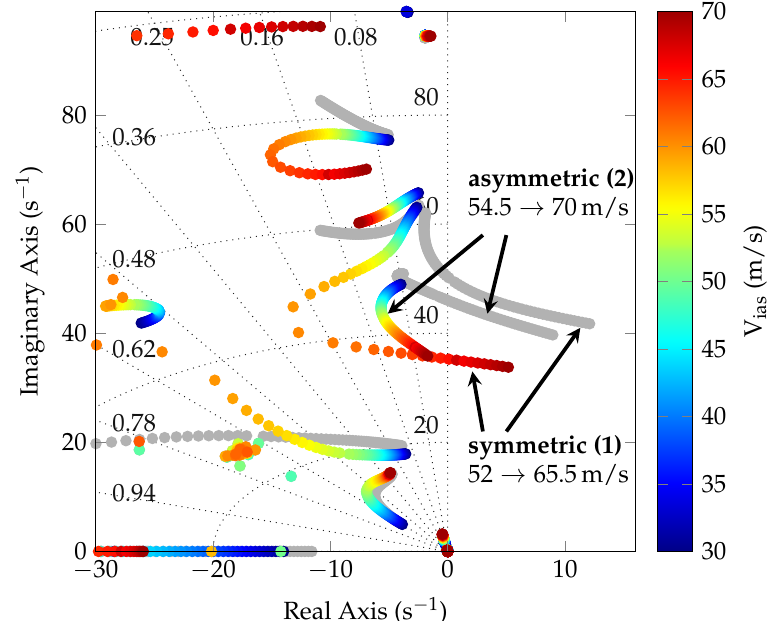
Figure 8. Comparison of the closed-loop poles with baseline controller only in gray and the closed-loop poles with baseline and flutter controller (colored) in dependence of the indicated airspeed V ias . Only the positive imaginary axis is depicted for readability